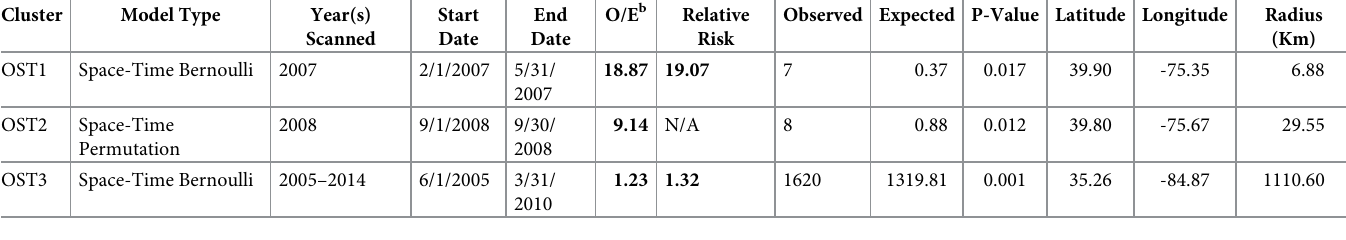
Table 5. Space-time clusters identified with the spatial scan statistic using Bernoulli and space-time permutation models, where there were statistically significant higher levels of dog-associated poisoning calls to the APCC a related to opioids in the continental US (2005–2014). Cluster Model